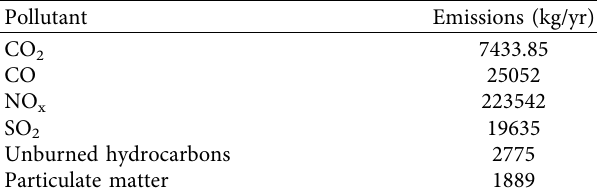
Figure 7: The result of 1MW landfill simulation by Homer. Table 6: Environmental analysis of the biomass power plant.